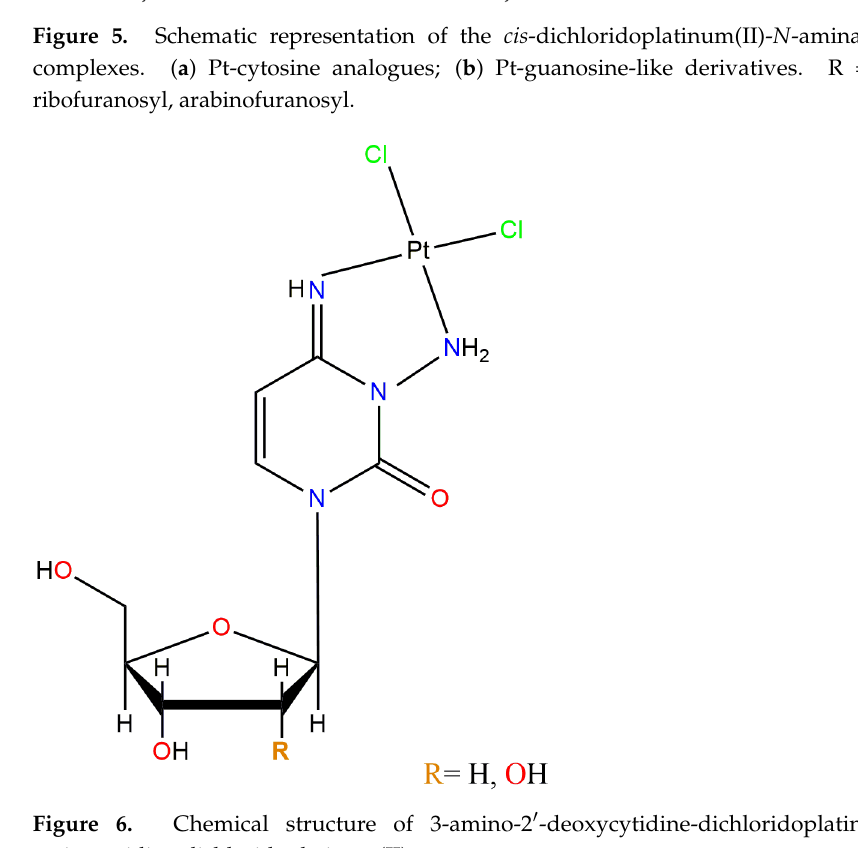
Figure 7. Structural formula of adenine, with the preferred coordination sites of platinum to nitro- gen evidenced. The atom numbering scheme, for nucleotides, is also reported. Summaries of the known biological activities of tested complexes were also reported. For the [PtCl 2 (Ado- N6 , N7 )] complex, in vivo tests against mice Sarcoma 180 cells were performed by Cleare and Hoeschele in 1973. Unfortunately, for the mentioned compound, low activity was showed [85].